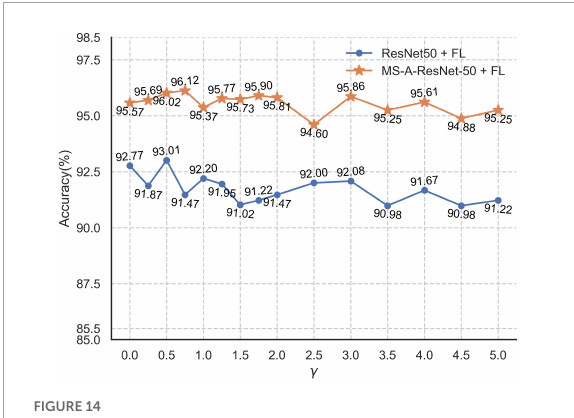
FIGURE14 Accuracy rates of ResNet50 + FL and MS-A-ResNet-50 + FL networks under different γ .